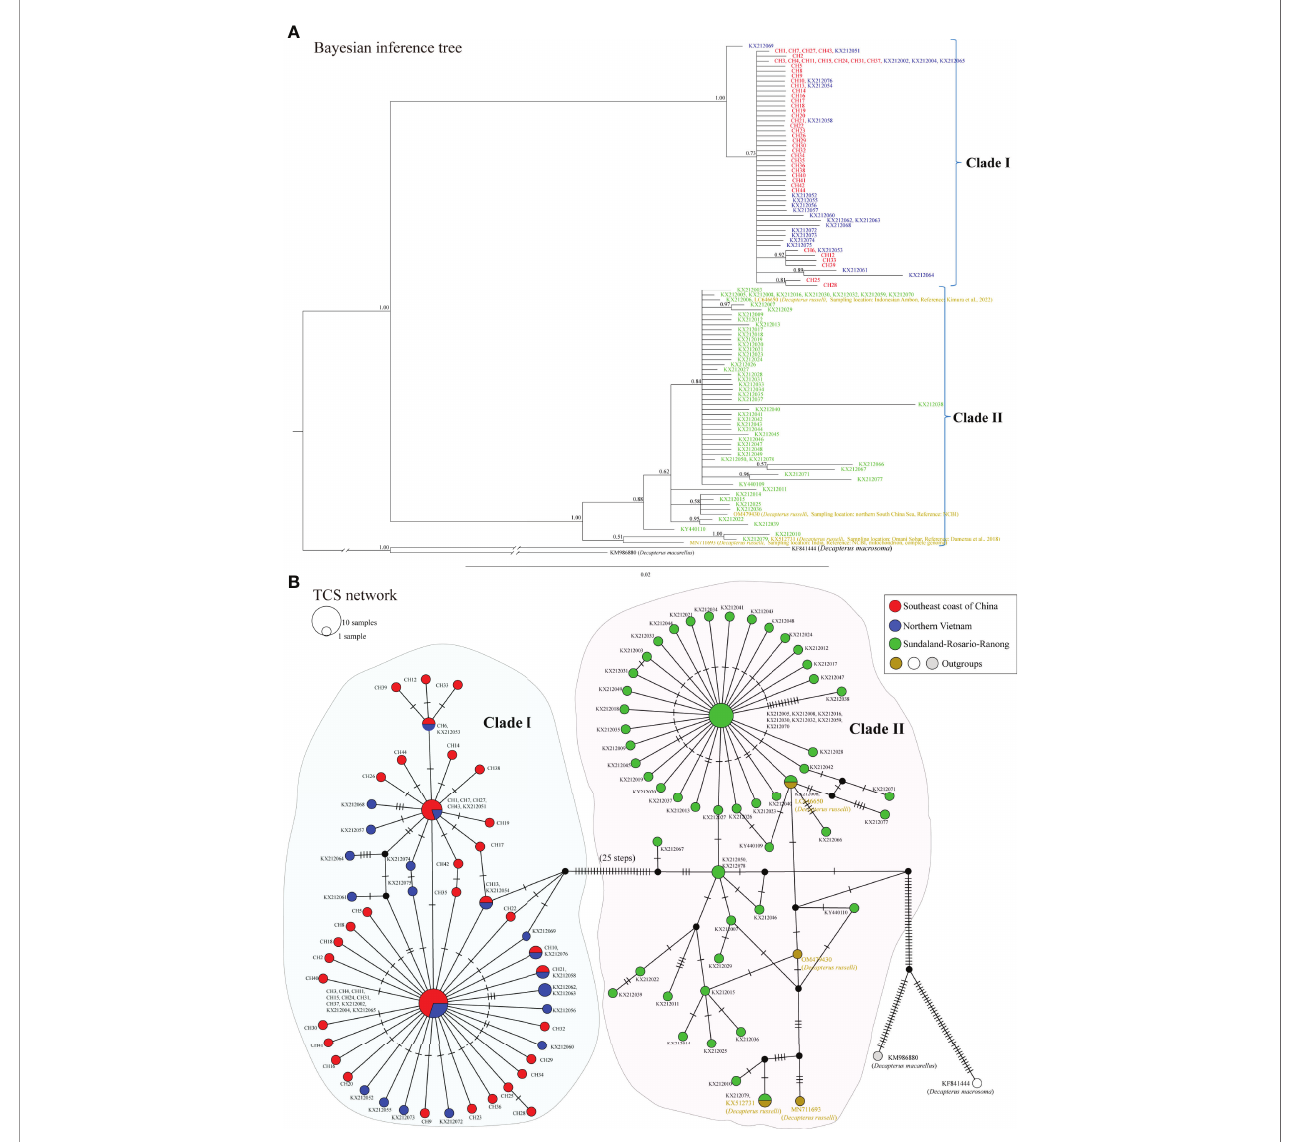
FIGURE 6 | Bayesian inference tree (A) and TCS haplotype network (B) constructed using 124 Cyt b haplotypes (606 bp) of named D. maruadsi from the southeast coast of China, northern Vietnam, and Sundaland-Rosario-Ranong. The congeneric species Decapterus russelli (GenBank accession numbers: